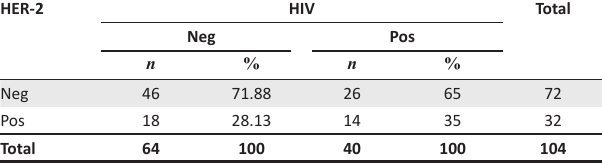
TABLE 3: Human epidermal growth factor receptor 2 status by human immunodeficiency virus status ( p = 0.5157). HER-2